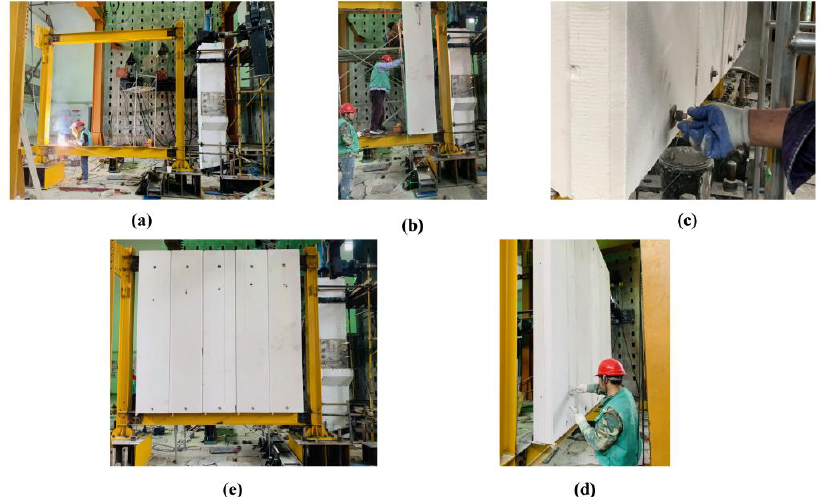
Figure 8. Images depicting the different stages of test piece installation: ( a ) installation of the steel frame; ( b ) installation of AAC wall panels; ( c ) installation of bolts; ( d ) application of mortar in AAC joints; ( e ) completed installation.